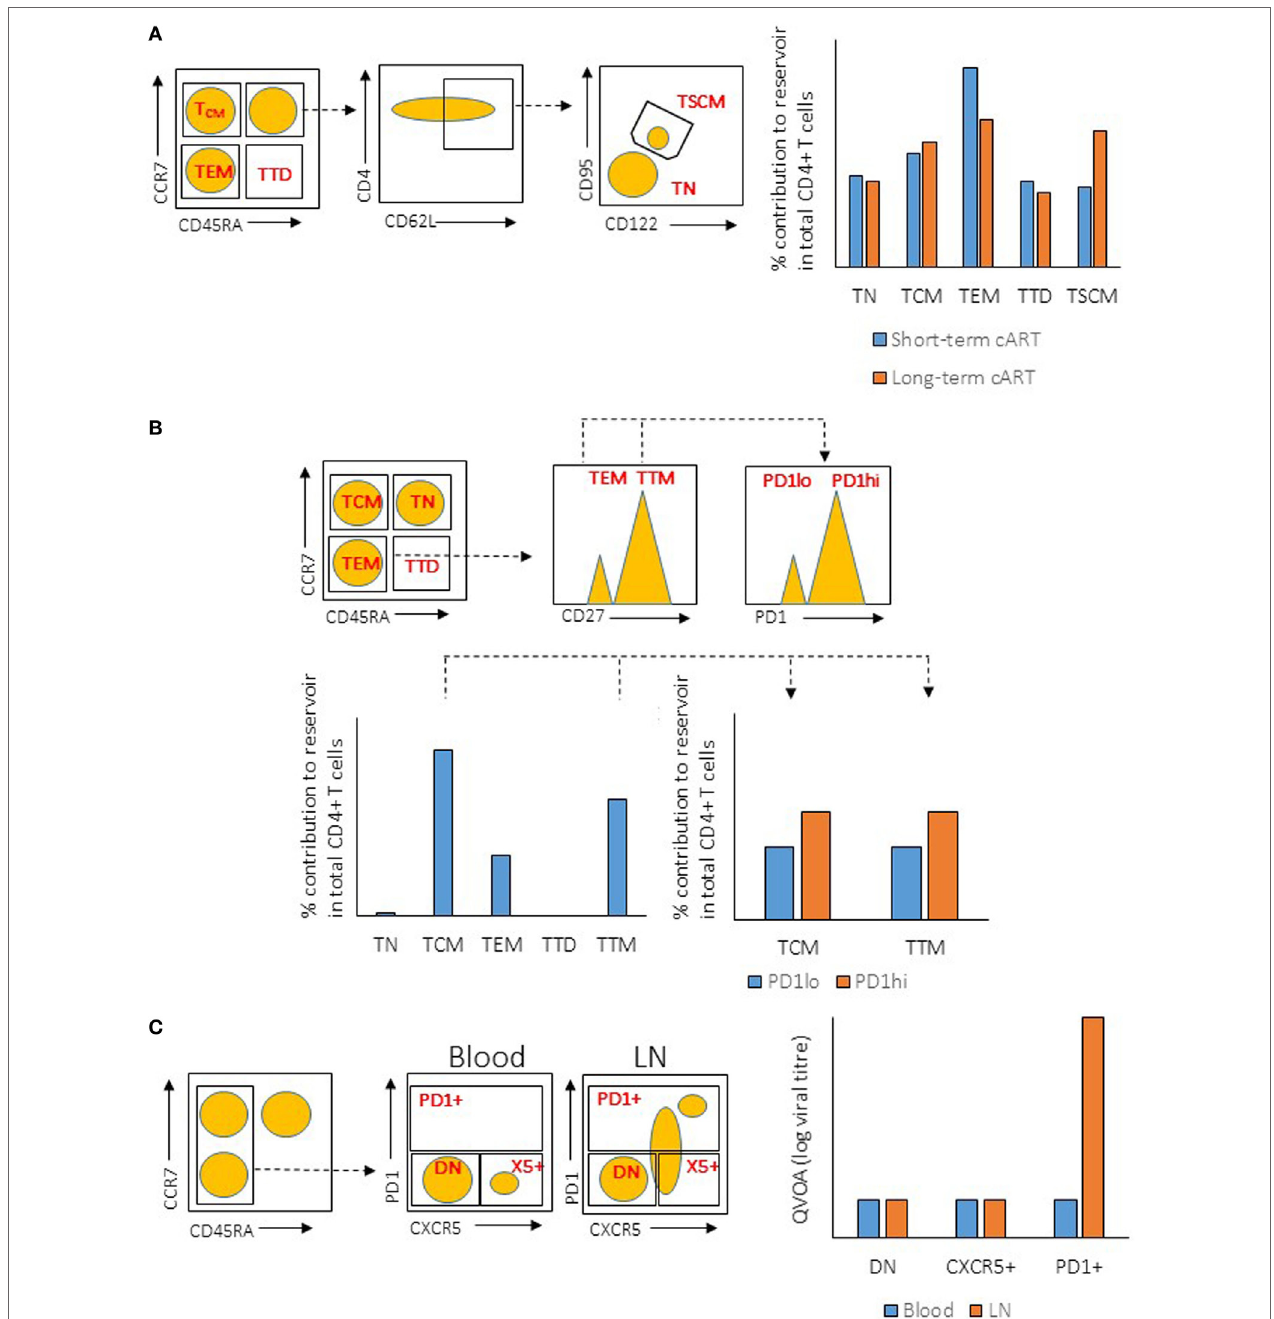
FigURe 1 | Illustration of gating strategies for CD4 + T cells subsets and their relative viral reservoir among different studies. (A) Gating strategy and CD4 + T cells reservoir characteristic from the study by Buzon et al. ( Left ) Plots show the gating strategy used to isolate the different population of CD4 + T cells from peripheral blood mononuclear cell (PBMC) (sorted population indicated in red). Dotted line indicates the subgating of the different subsets. ( Right ) Level of integrated proviral DNA from the sorted CD4 + T cells subsets was determined by PCR after short-term or long-term combination antiretroviral therapeutic regimen (cART). (B) Gating strategy and CD4 + T cells reservoir characteristic from the study by Chomont et al. ( Left ) Plots show the gating strategy used to isolate the different population of CD4 + T cells from PBMC (sorted population indicated in red). Dotted line indicates the subgating of the different subsets. ( Right ) Level of integrated proviral DNA from the sorted CD4 + T cells subsets was determined by PCR. (C) Gating strategy and CD4 + T cells reservoir characteristic from the study by Banga et al. ( Left ) Plots show the gating strategy used to isolate the different population of CD4 + T cells from PBMC or lymph node (LN) tissues (sorted population indicated in red). Dotted line indicates the subgating of the different subsets. ( Right ) ELISA for viral antigen P24 was used to quantify the level of virus production from the sorted CD4 + T cells subsets after stimulation by anti-CD3/CD28 antibodies [quantitative viral outgrowth assay (QVOA)]. TN, naïve T cells; TTD, terminally differentiated T cells; TEM, effector memory T cells; DN, double-negative